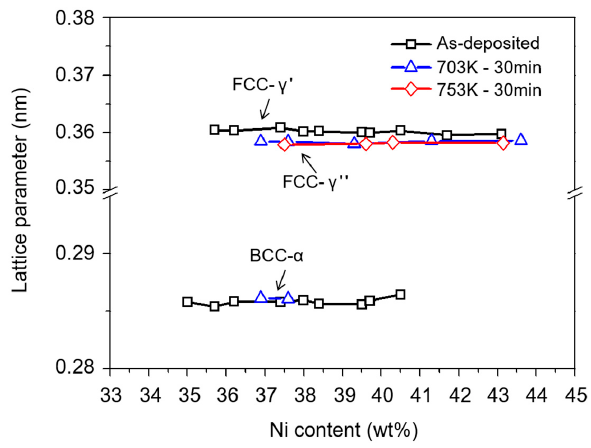
Figure A1. Abnormal grain growth occurring in the FCC phase. The EBSD map shows abnormal grain growth occurring during annealing at 673 K (400 °C) for 1 min in the electroformed Fe-43 wt % Ni alloy consisting of the single γ′ phase. The dark area indicates the nanometer-sized crystallites smaller than the step size of the EBSD scanning.